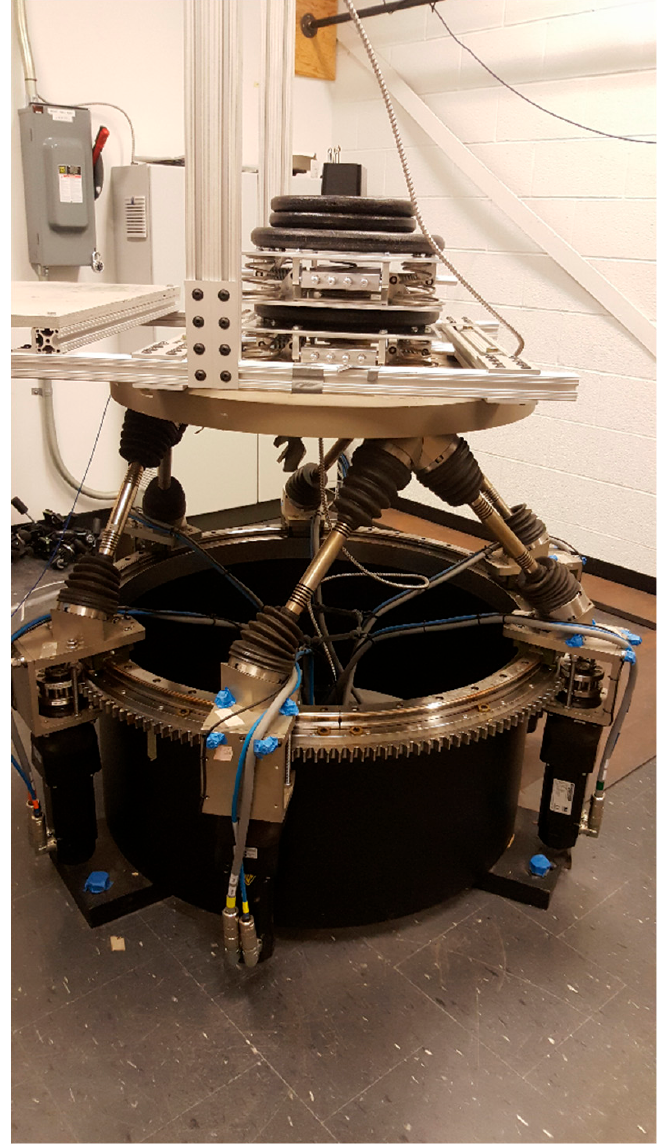
Figure 5. Mikrolar 6DOF robot with the 2DOF QZS placed on top. Each layer of the 2DOF QZS system was built so that it could easily be reconfigured as a linear system by removing the oblique springs. This facilitates the investigation of behaviors of various combinations of linear and nonlinear systems. The physical properties of the two individual halves of the system are summarized in Table 1. The masses of m 1 and m 2 are estimated by summing the mass of any platforms and static components touching the masses, as well as half of the dynamic components associated with the mass. In the case of m 1 , this includes the masses at the top of the 2DOF structure, the platform directly underneath them, and half the mass of the dynamic components associated with k 11 and k 31 . For m 2 it includes the mass in the center of the two halves, both the platforms sandwiching it, as well as half the upper and lower dynamic components. While completing each test, the tuned amount of mass was placed onto the system such that each SDOF rested at the QZS condition during static